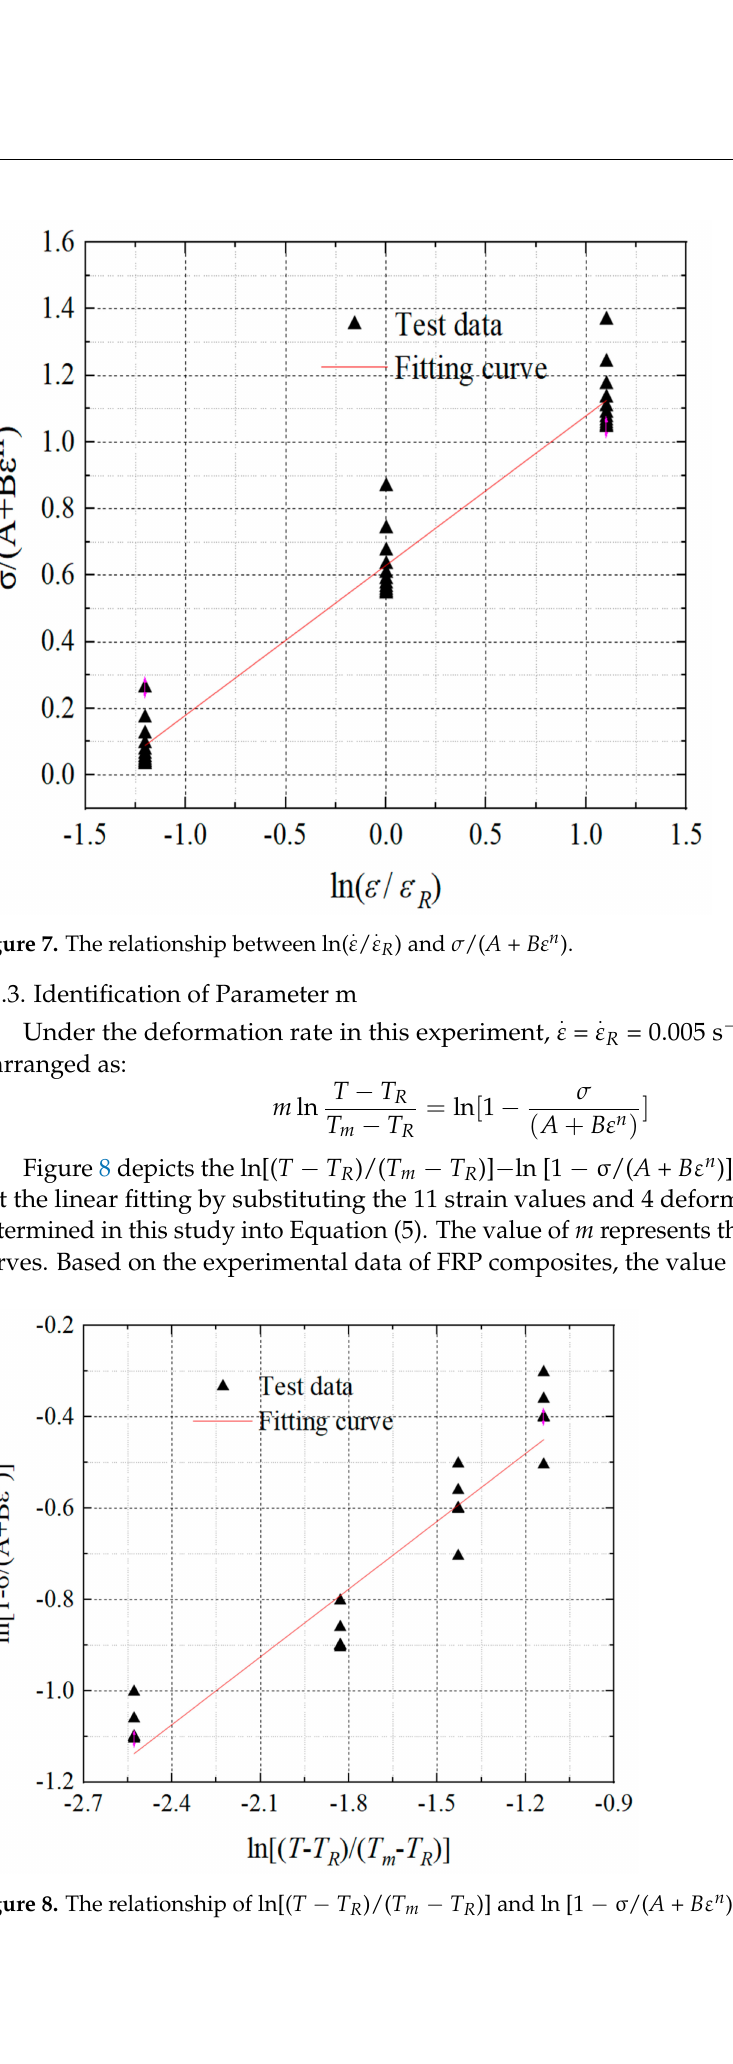
Figure 8. The relationship of ln[( T − T R )/( T m − T R )] and ln [1 − σ /( A + B ε n